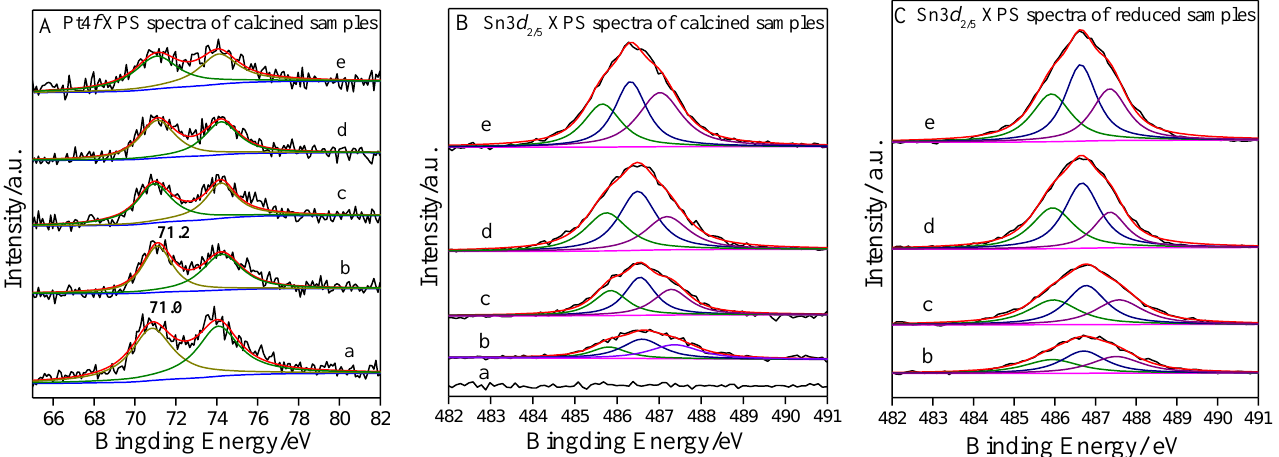
Figure 4. Pt4 f ( A ) and Sn3 d 5/2 ( B , C ) XPS spectra of calcined and reduced PtSn/DMSN catalysts with different ratios of Pt and Sn: (a) Pt/DMSN, (b) Pt 1 Sn 1 /DMSN, (c) Pt 1 Sn 2 /DMSN, (d) Pt 1 Sn 3 /DMSN, (e) Pt 1 Sn 4 /DMSN.